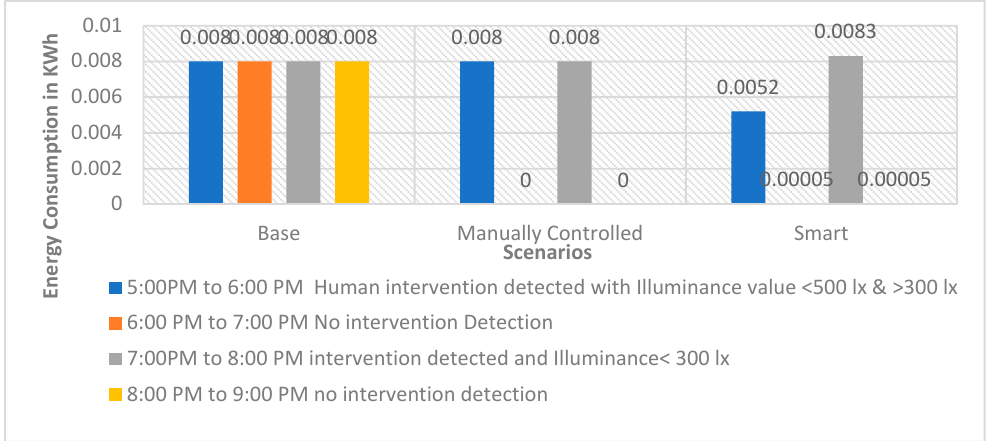
Figure 7. Graph for Energy Consumption of 8 W LED Light Bulb in three scenarios. PARSLAD with the 8 W LED bulb gives 57.5% and 15% of energy consumption reduction in comparison to the base and manually controlled scenario, respectively. Thus, the device works e ffi